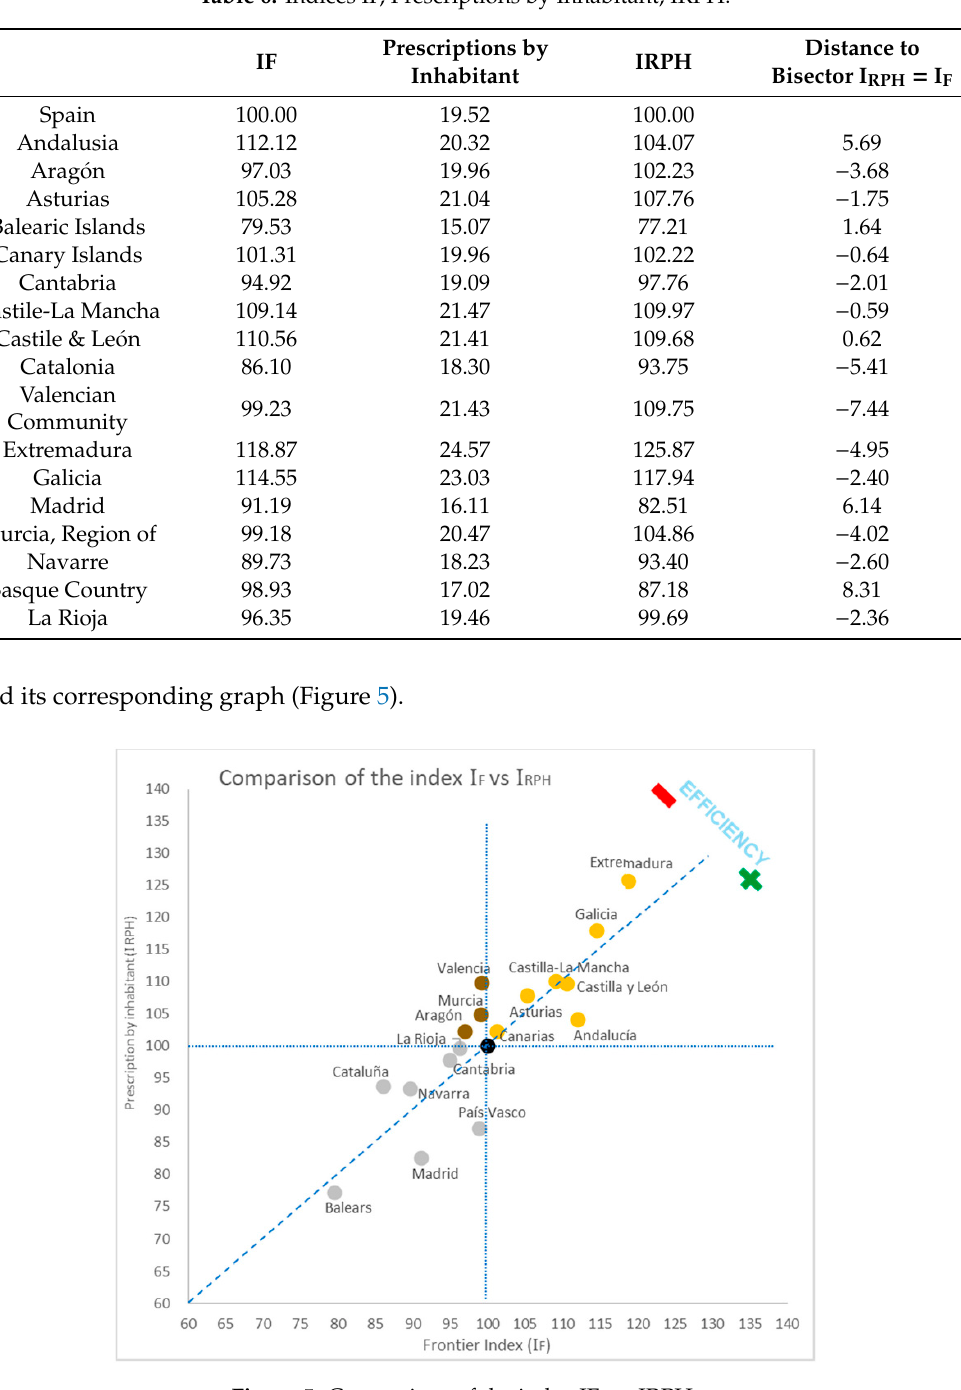
Table 7. Indices IF, Health Expenditure by Inhabitant, IGSH.